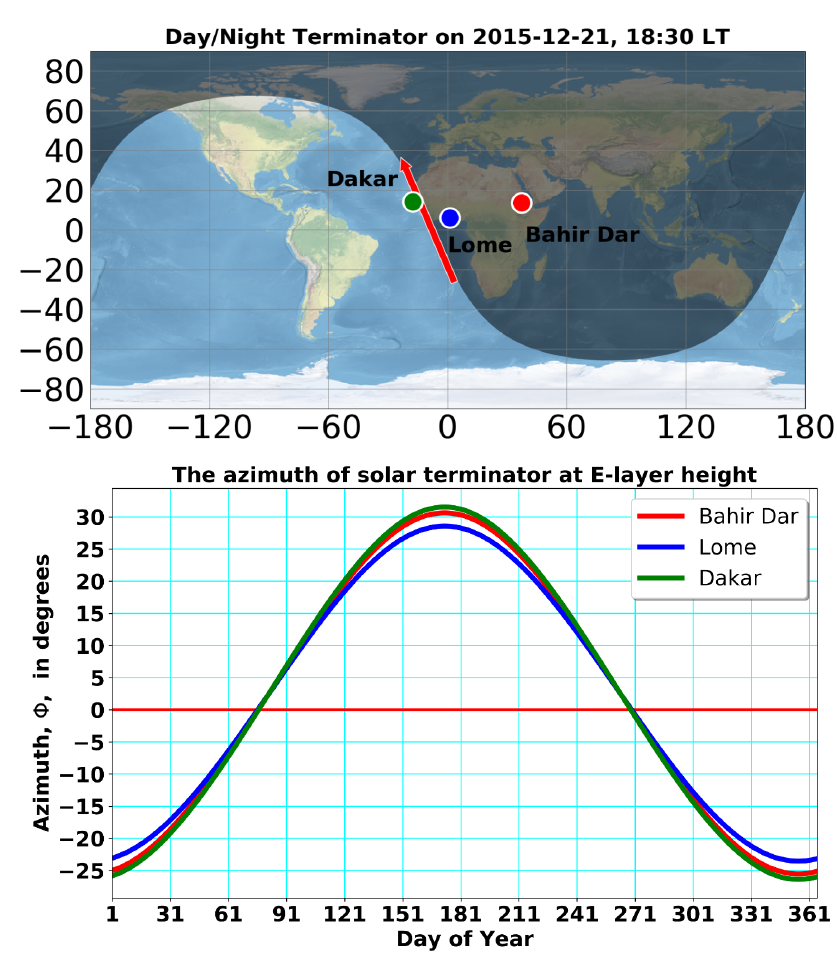
Figure 5. African observation sites used in this study ( upper panel ). The azimuth of the sunset terminator or azimuth at an altitude of 120 km from the ground ( lower panel